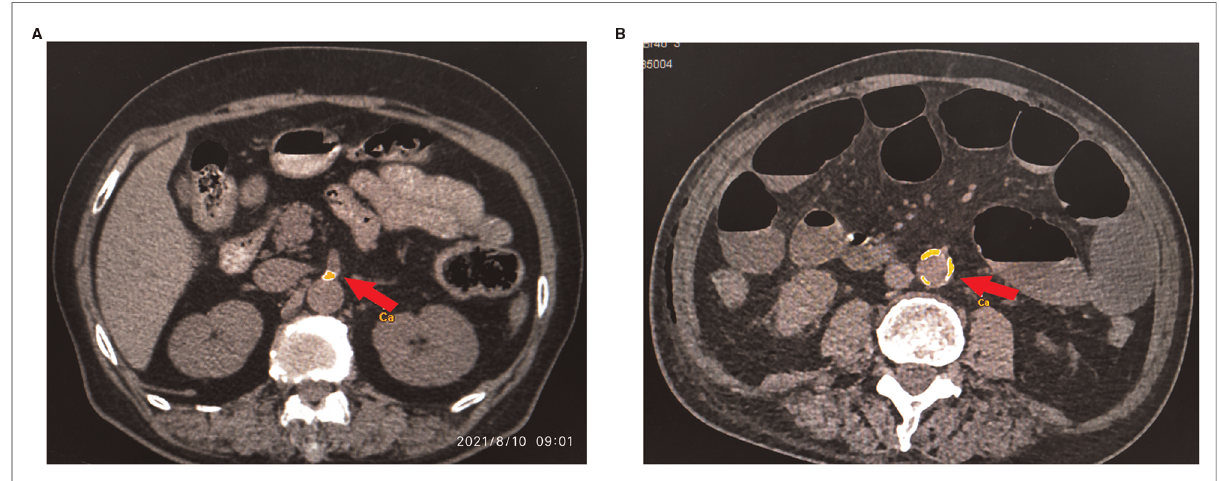
FIGURE 1 The MDCT images of abdominal aorta, SMA and IMA calci fi cation. The arrow in the images indicates the site of arterial calci fi cation. The plaque was outlined, and then its area was obtained by the software (Syngo Calcium Scoring, Siemens). ( A ) The calci fi cation at the origin of SMA on the aorta. ( B ) The calci fi cation of the abdominal